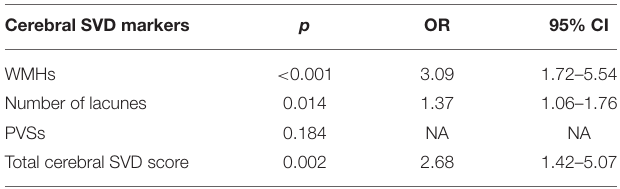
TABLE 3 | Logistic regression analysis of relationships between cerebral SVD markers and post-operative cerebral